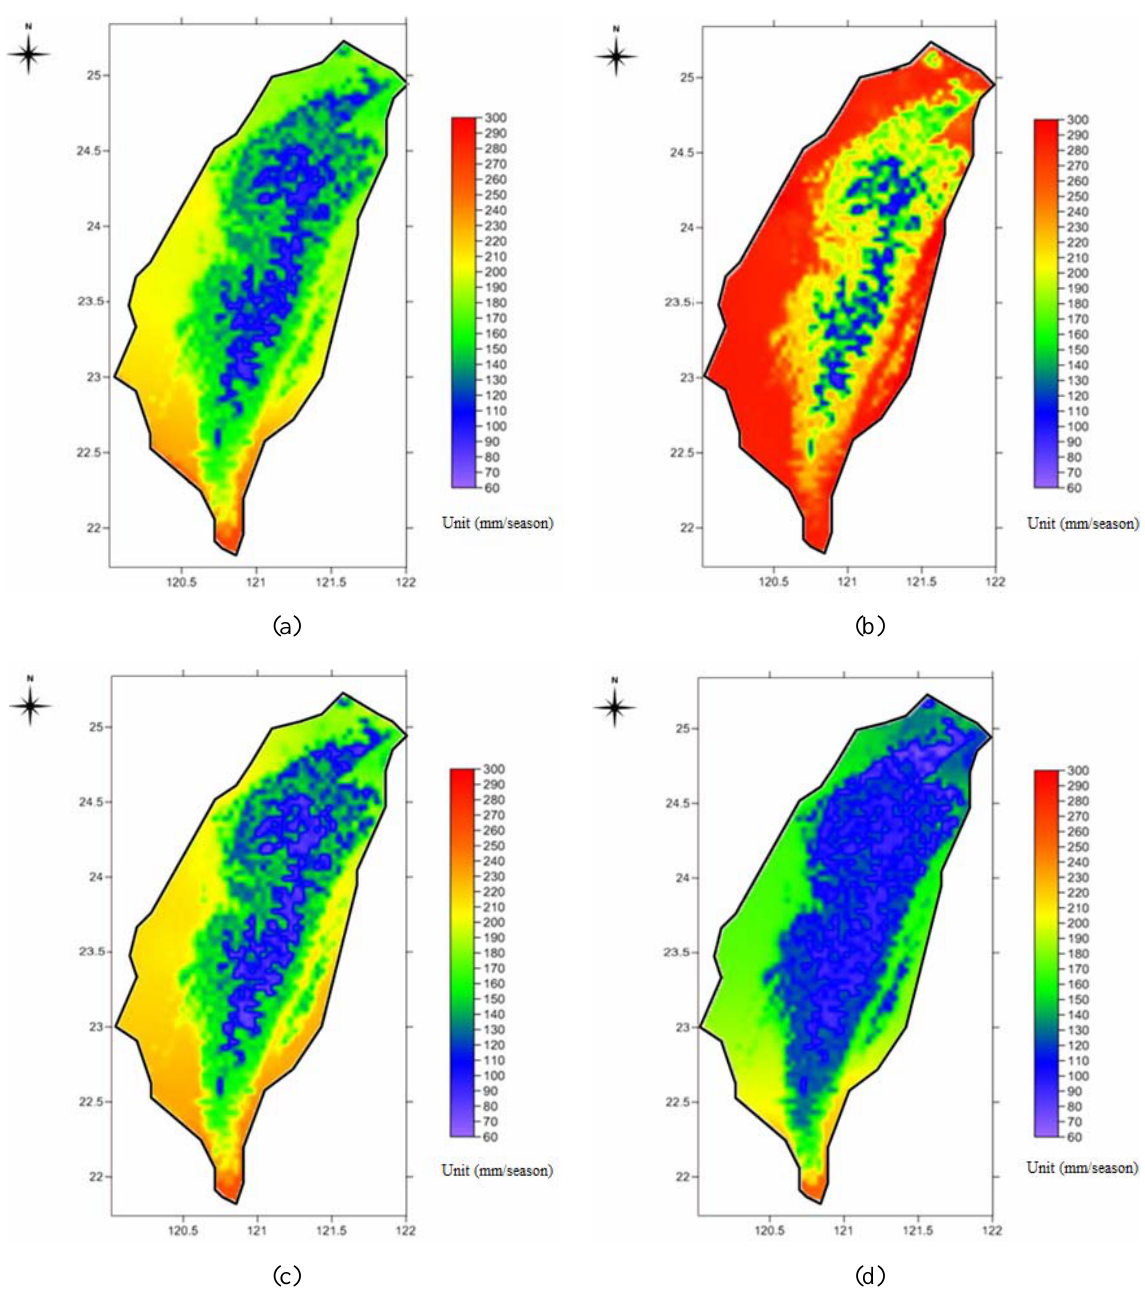
Fig. 9. Spatial distribution of evaporation estimated by the AK model for (a) Spring, (b) Summer, (c) Fall and (d) Winter. ungauged sites. In sum, the contribution of this study greatly enhances the ANN-based model for displaying the spatial distribution of pan evaporation, for reflecting the impacts of geographical features on the estimation of pan evaporation, and for estimating pan evaporation at ungauged sites, which are difficult to be achieved by a single ANN